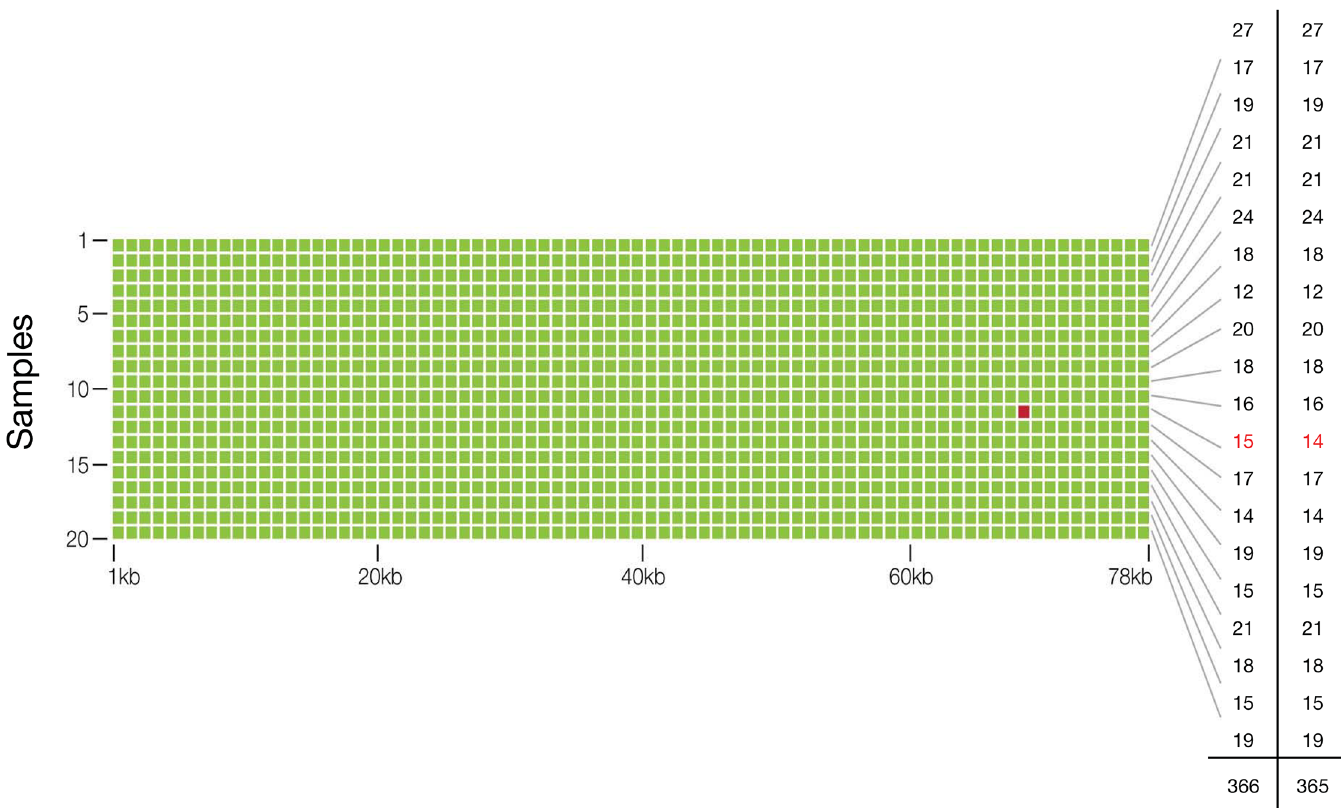
Fig 3. Analytic Specificity and Sensitivity, and Diagnostic Accuracy of the Guardant360 cell-free circulating tumor DNA assay. The matrix illustrates that a targeted region of 78 kbp was sequenced in each of 20 samples to identify single nucleotide variants at approximately 2.0 – 5.0% MAF (heterozygous) in circulating cfDNA. Green dots represent concordant single nucleotide variant (SNV) calls for digital sequencing of 10 ng cfDNA to calls made by whole exome sequencing of 2 μ g of genomic (leukocyte) DNA from the same sample. The red dot represents the single false positive result in a cumulative 1.56 million bases sequenced. The far right-hand column illustrates the number of SNVs per sample identified with exome sequencing, and the penultimate column with digital sequencing, for a total of 365 and 366 SNVs, respectively.